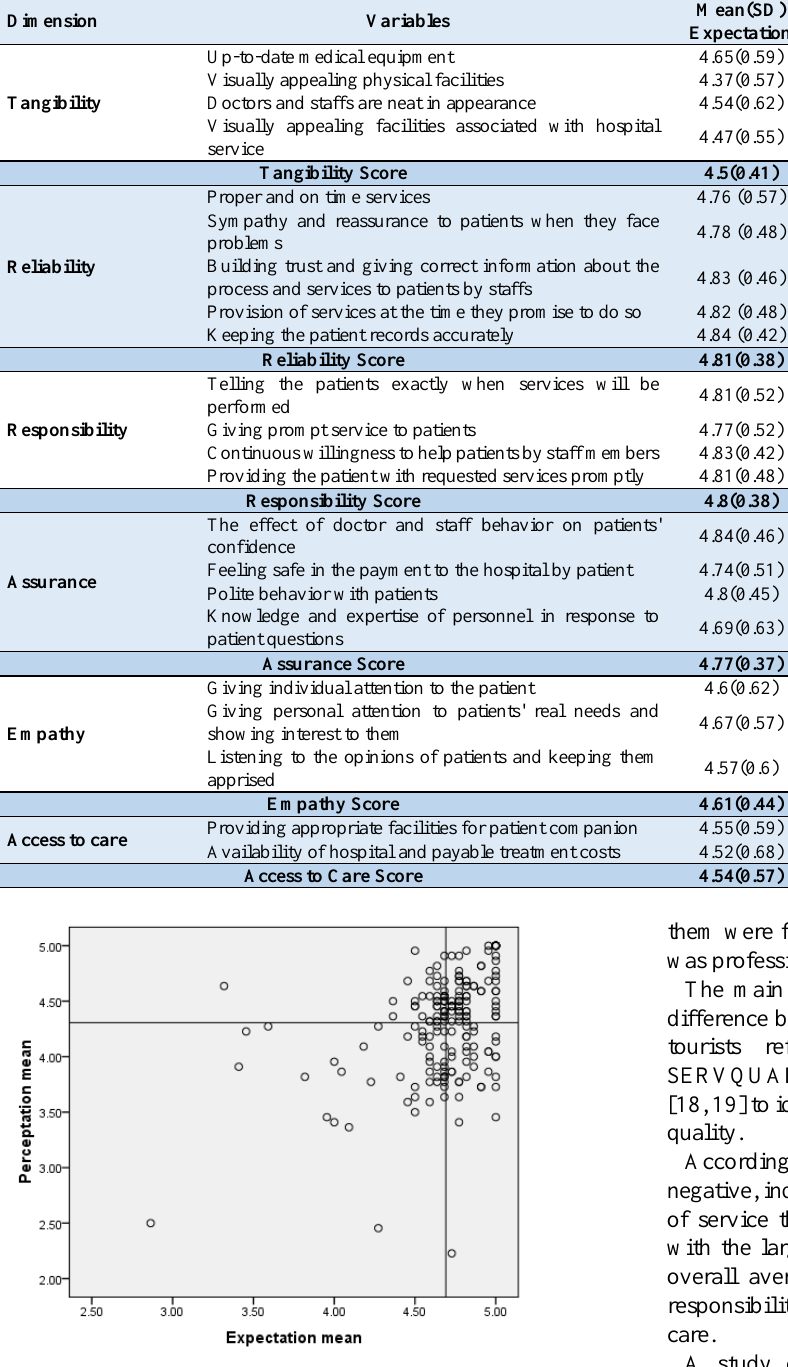
Variables Dimension